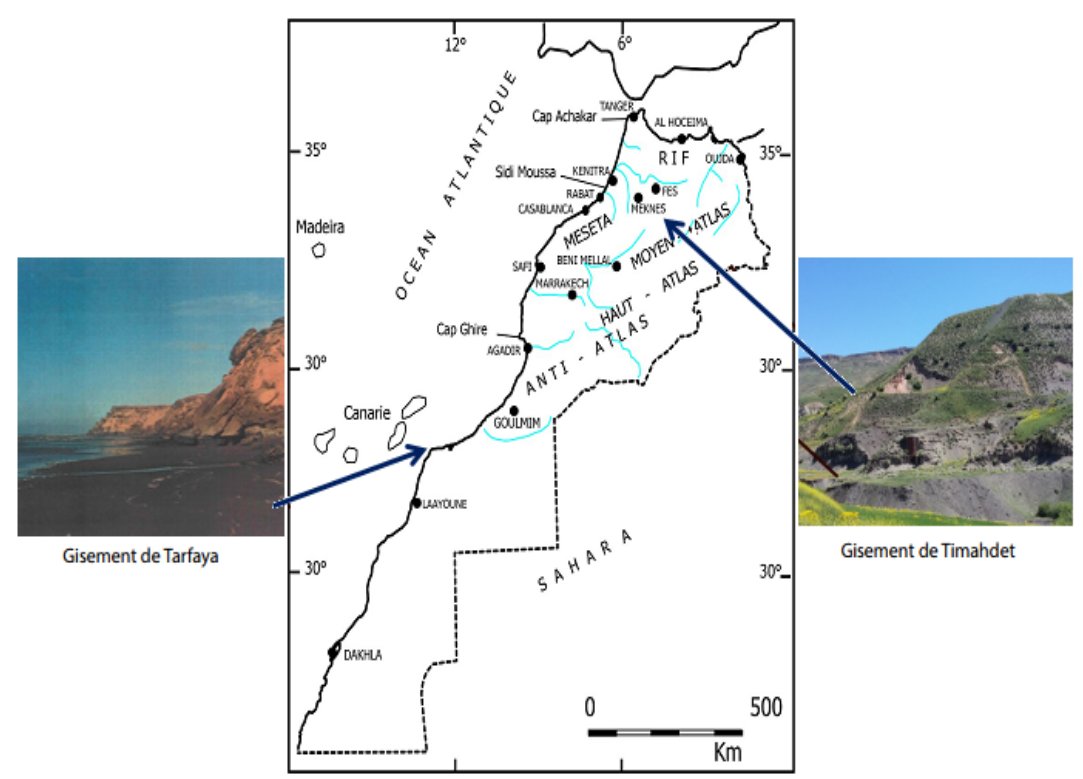
Figure 1. Location of the main oil shale deposits in Morocco .